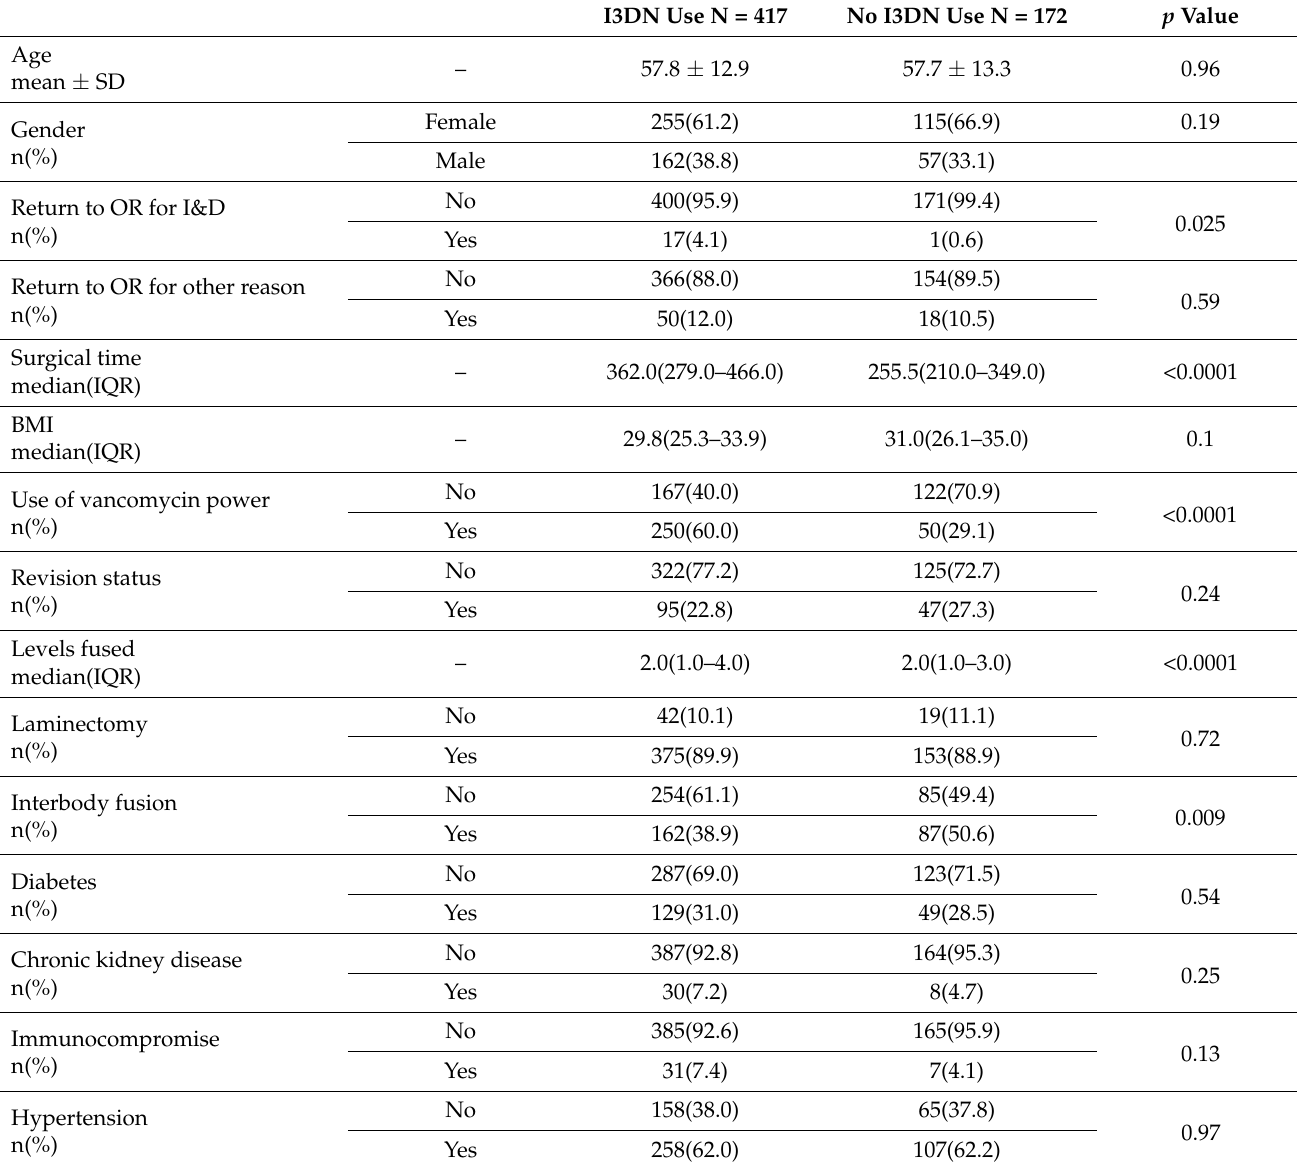
Table 1. Demographic and clinical characteristics by I3DN use in 589